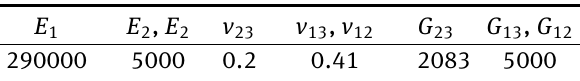
Table 1: Relevant material properties of unidirectional GY70/epoxy with fiber-volume fraction v f = 0.6 (moduli in MPa ).